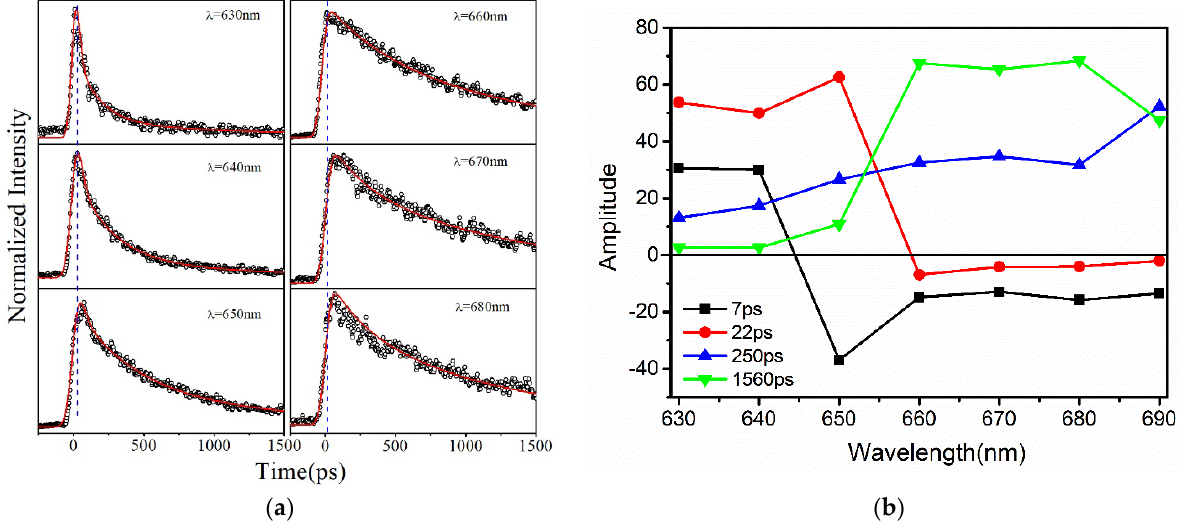
Figure 4. Time − resolved spectra results: ( a ) Fluorescence intensity decay curves and fitting results of C − PC hexamer at 77 K. Excitation was done at 570 nm ( b ) The fluorescence decay-associated spectra of C − PC hexamer.